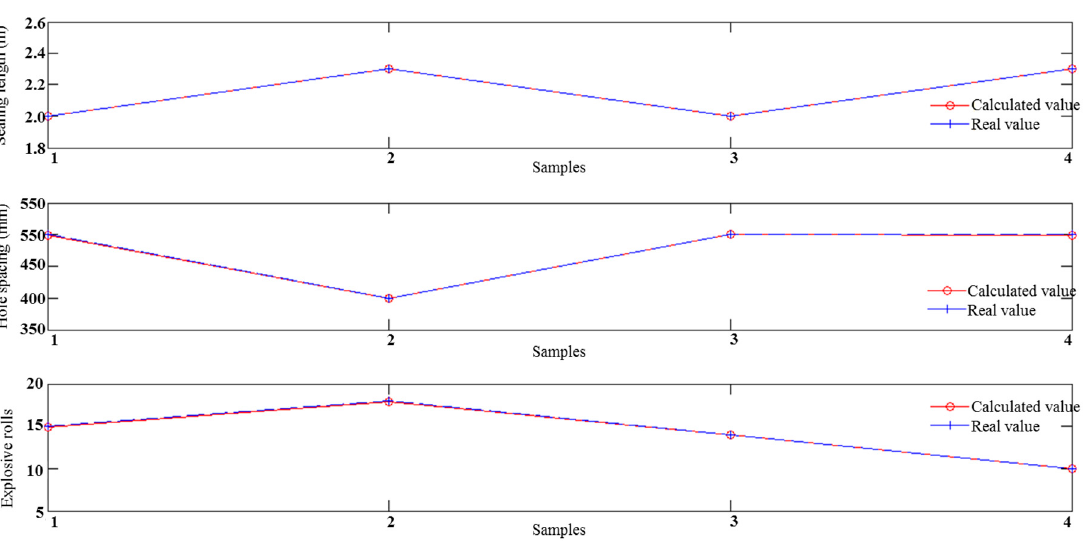
Figure 15. Training result of neural networks.